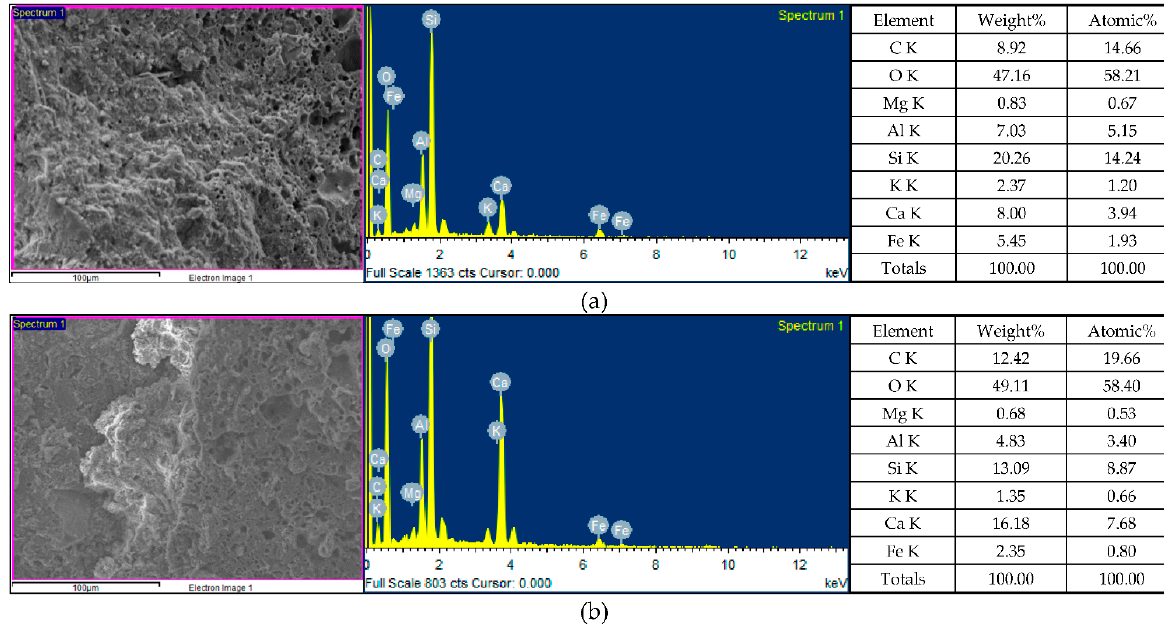
Figure 12. EDS analysis of the concrete specimens after self-healing for 14 days: ( a ) control group; ( b ) experimental group.